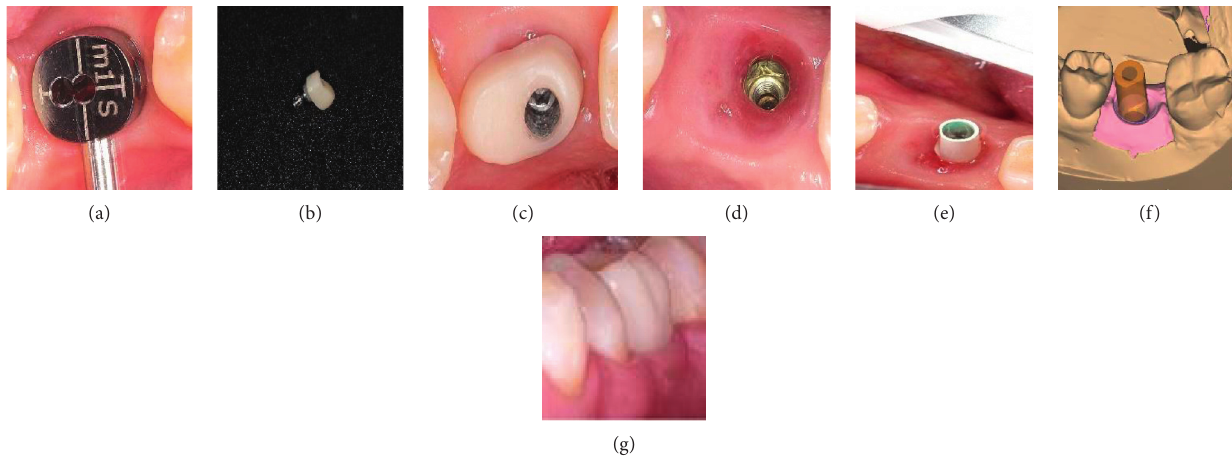
Figure 10: Stages of fabrication of a permanent prosthesis after the formation of the emergence profile with a customized composite abutment: (a) planning, (b) a customized composite abutment, (c) the abutment placement (3 weeks after surgery), (d) formation of the emergence profile (10weeks), (e) intraoral scanning, (f) planning of a permanent prosthesis in the program, and (g) placement of a permanent prosthesis.